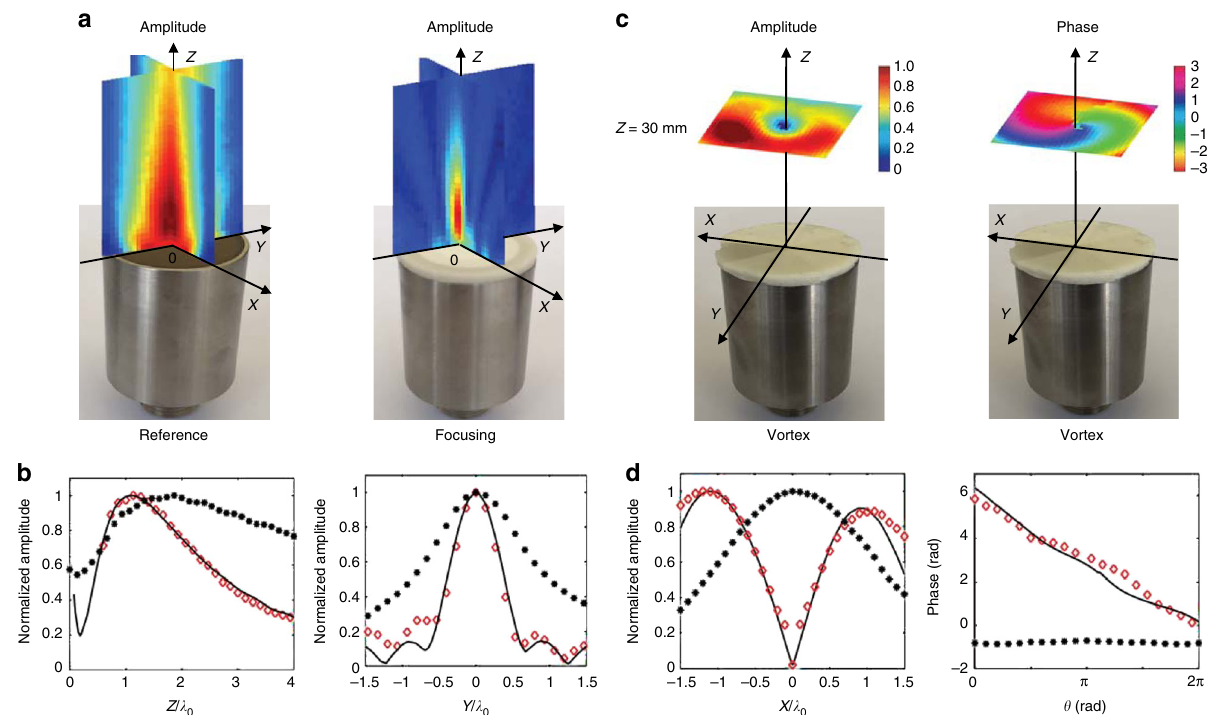
Fig. 3 3D focusing of ultrasound and acoustic vortex generation. a Acoustic fi eld patterns measured at 200 kHz in the XZ and YZ planes (30 mm × 30 mm) without (reference) and with (focusing) the circular radial GRIN metasurface (Fig. 1d) deposited on a 1-inch-diameter ultrasonic immersion transducer. b Normalized amplitude fi eld distributions along the Z -axis for X = 0 mm and Y = 0 mm (left) and along the Y -axis for Z = 9 mm and X = 0 mm (right). The full widths at half maximum peaks are 2.4 λ 0 and 0.8 λ 0 along the Z -axis and Y -axis, respectively. c Amplitude and phase of the acoustic fi eld measured at 150 kHz in the XY plane (30 mm × 30 mm) at Z = 30 mm with the circular azimuthal GRIN metasurface (Fig. 1e) deposited on the same transducer as in a . All the key features of an acoustic vortex are evident here: the amplitude of the wave fi eld is null at the center, while the phase is winding linearly along that point. d Normalized amplitude and phase fi eld distributions along the X -axis and the angle θ , respectively. For all distributions displayed here, open red symbols refer to measurements with the metasurface, while fi lled black symbols correspond to reference measurements without the sample. Solid lines refer to numerical simulations obtained with the